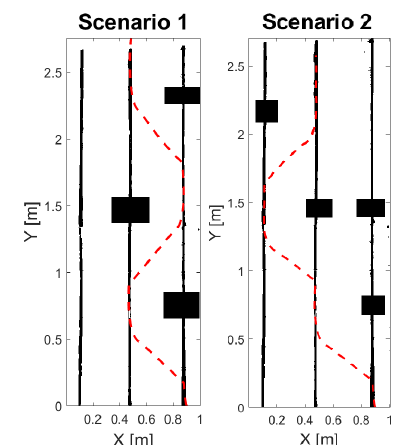
Figure 6. Simulation testing with two scenarios: zig-zag scenario in the left and double lane change scenario in the right. The dotted-line is the path of the WMR.